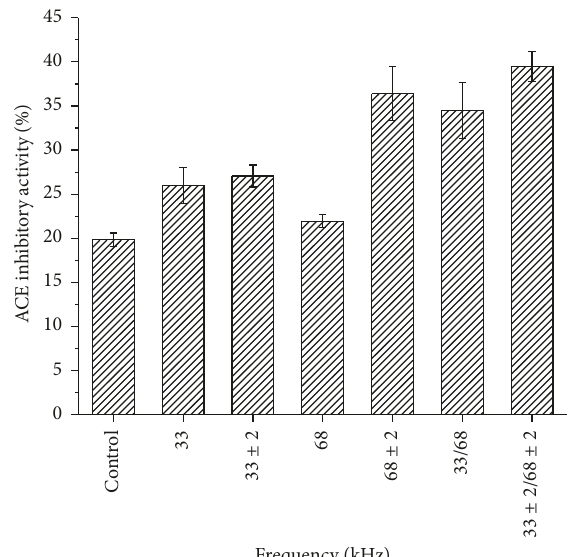
Figure 2: Effects of pretreatment with ultrasound bath with four different working modes and two frequencies on the ACE inhibitory activity of zein hydrolysates.